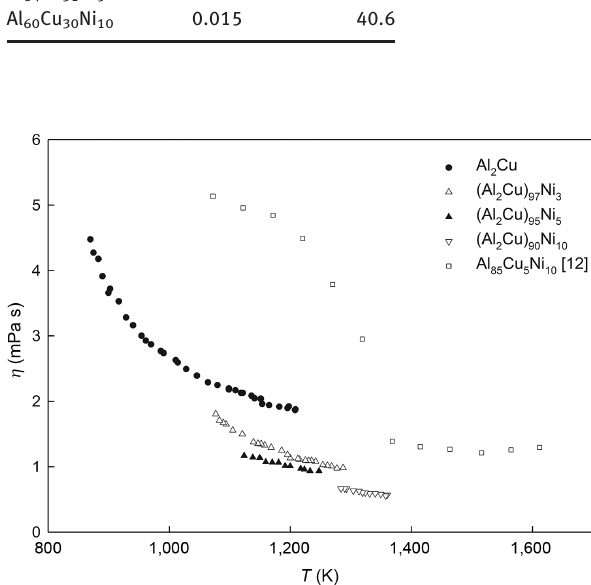
Figure 3: Temperature dependence of the viscosity for liquid Al – Cu – Ni alloys.